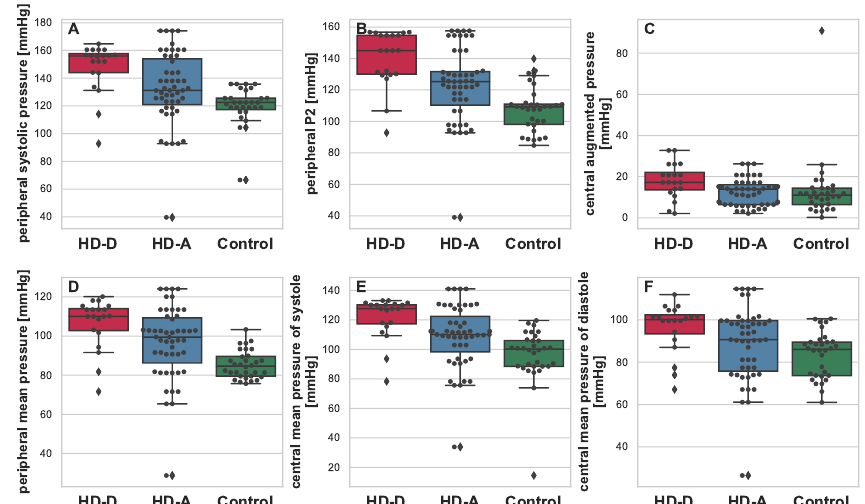
Figure 4. Boxplot depicting differences between HD-D (red), HD-A (blue), and Control (green) for the chosen variables: peripheral systolic pressure ( A ), peripheral P2 ( B ), central augmented pressure ( C ), peripheral mean pressure ( D ), central mean pressure of systole ( E ), and central mean pressure of diastole ( F ). Additional swarmplot was overlaid onto the original plot in order to mark the obtained measurements for each of the patients (dots). Outlier values are represented by diamons.